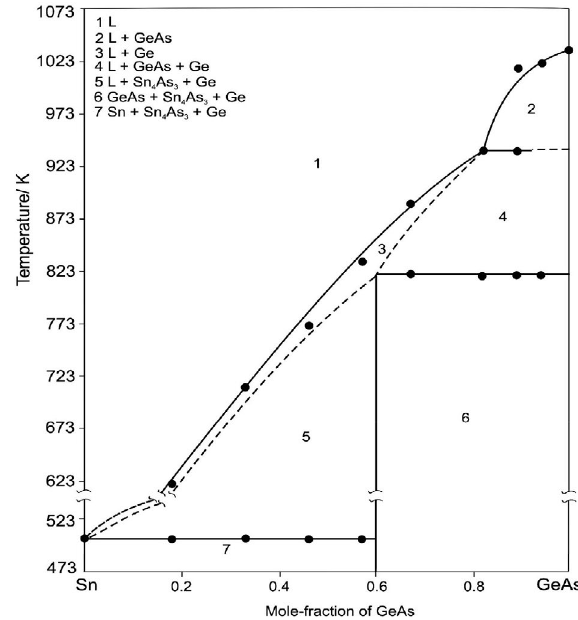
Figure 3. T-x diagram of the polythermal section Sn–GeAs.